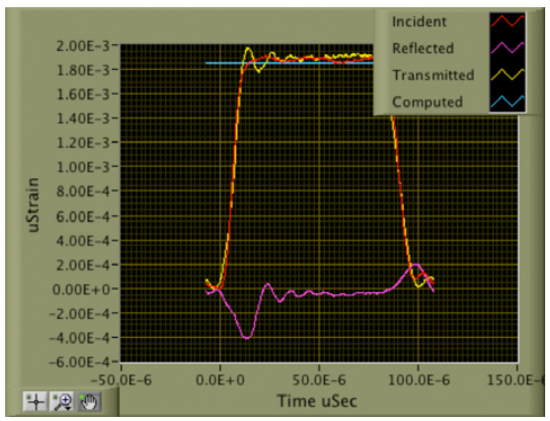
Fig. 7. HSR test result of Stress-Proof. Impact velocity of 21.9 m / s.